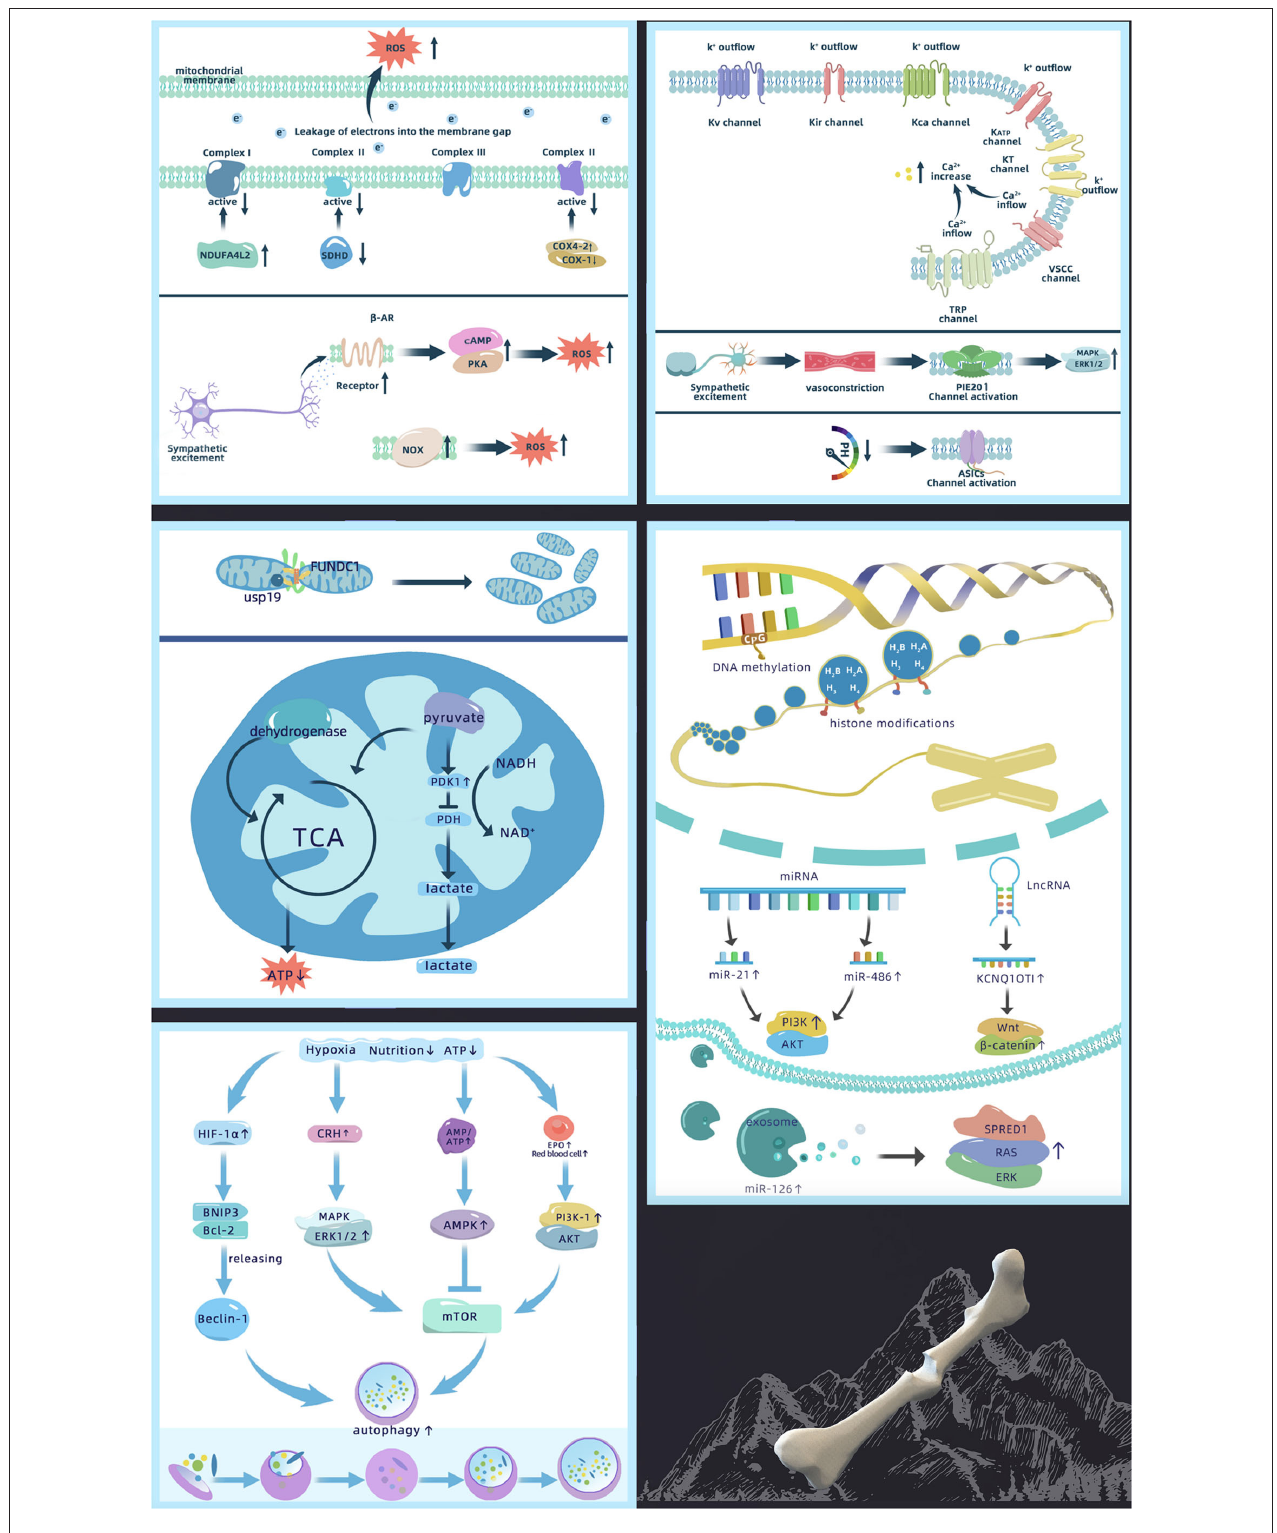
FIGURE 2 | Mechanism of abnormal bone defect repair in high-altitude, including changes in ion permeability of the cell membrane, ROS production, changes in mitochondrial function, activation of autophagy, and epigenetics regulation [Akt, protein kinase B; AMPK, adenosine 5 ′ -monophosphate-activated protein kinase; ASIC, acid sensitive ion channel; ATP, adenosine triphosphate; Bcl-2, B-cell lymphoma 2; BNIP3, Bcl-2 19 kDa interacting protein 3; COX, cytochrome C; CRH,